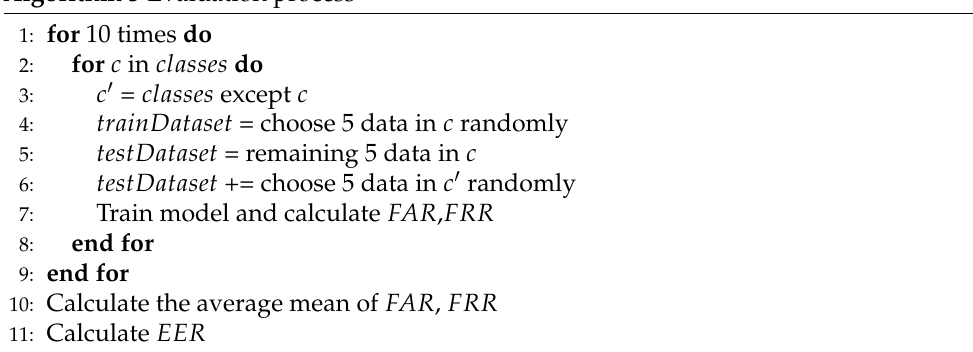
Algorithm 3 Evaluation